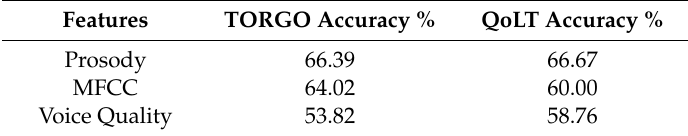
Table 8. Severity assessment accuracy scores with acoustic measures.